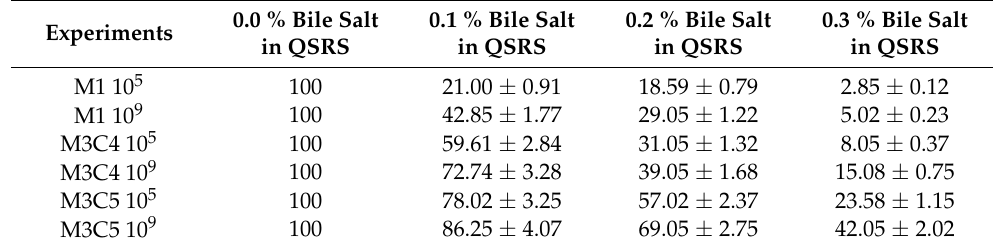
Table 5. The bile salt resistance of the studied